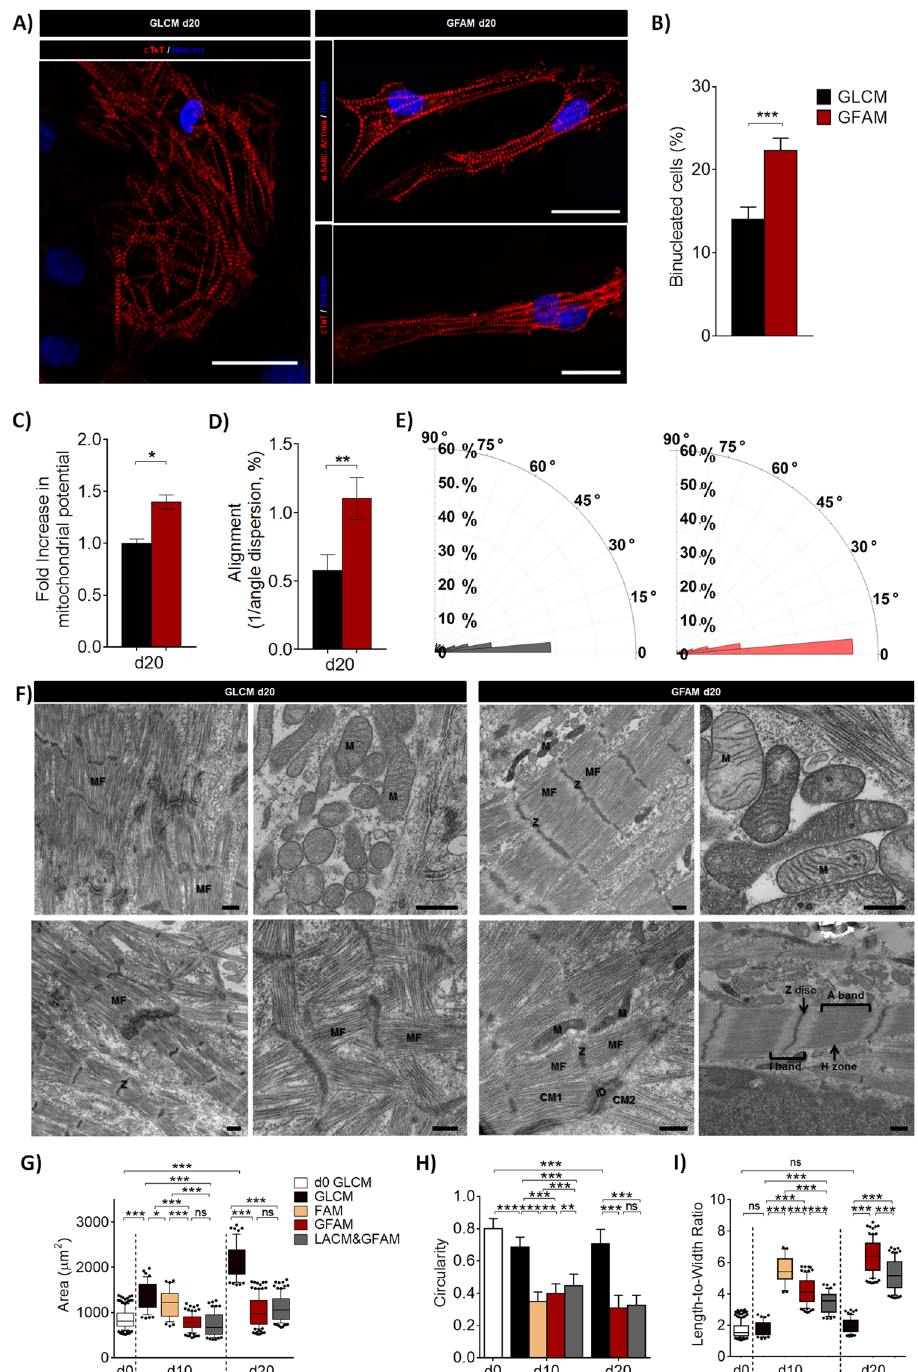
Figure 5. Structural and ultrastructural analyses of hiPSC-CMs after culture in different media. ( A ) Representative images of hPSC-CMs immunostained for cardiac troponin-T (cTnT) and α -sarcomeric actinin (red). Nuclei (blue) were stained with Hoechst 33342. Scale bars = 30 μ m. ( B ) Percentage of binucleated hiPSC- CMs in GLCM and GFAM (n > 20 per condition). C ) Fold increase in mitochondria potential assessed by the mitochondria specific dye Mitoview. Fluorescence values were normalized for the values obtained in cells cultivated in GLCM. (D-E) Sarcomere alignment in hiPSC-CMs cultured for 20 days in GLCM and GFAM: ( D ) Inverse of the magnitude of sarcomere angle dispersion and ( E ) Rose plot histogram of sarcomere orientation. n > 30 sarcomeres per condition. ( F ) TEM images of hiPSC-CMs. Myofibrils (MF), Z-disks (Z), sarcomeric bands: A- and I-bands with a H-zone, intercalated disks (ID) connecting adjacent CMs and Mitochondria (M) are highlighted. Scale bars = 500 nm. ( G – I ) Cell structure characterization in terms of cell area ( G ), circularity index ( H ), length-to-width ratio ( I ). n > 70 cells per condition from at least 5 separate experiments. Data are represented as mean ± SD. * p < 0.05; ** p < 0.01; *** p < 0.001; ns, not